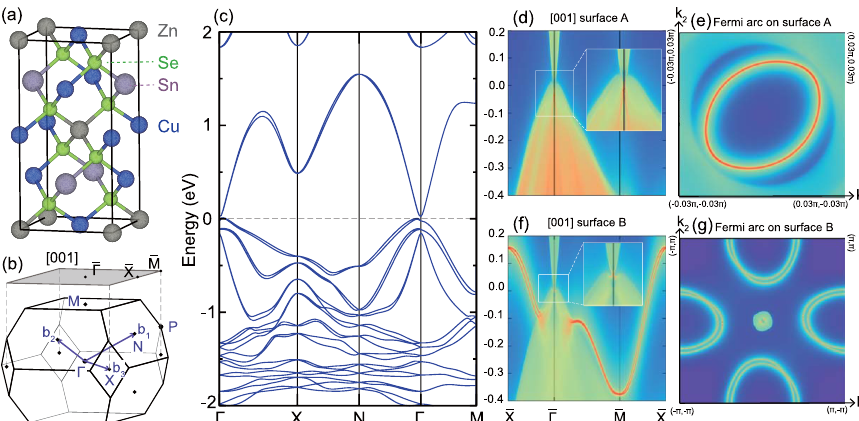
Fig. 5 First-principle calculations on Cu 2 ZnSnSe 4 . a Crystal structure of Cu 2 ZnSnSe 4 . b Brillouin zone and surface Brillouin zone along [001] direction. c Electronic structure with spin-orbit coupling for the bulk. d – e Surface states and Fermi arcs calculation on the [001] surface with Cu-Sn layer termination (surface A). f – g Surface states and Fermi arcs calculation on the [001] surface with Se layer termination (surface